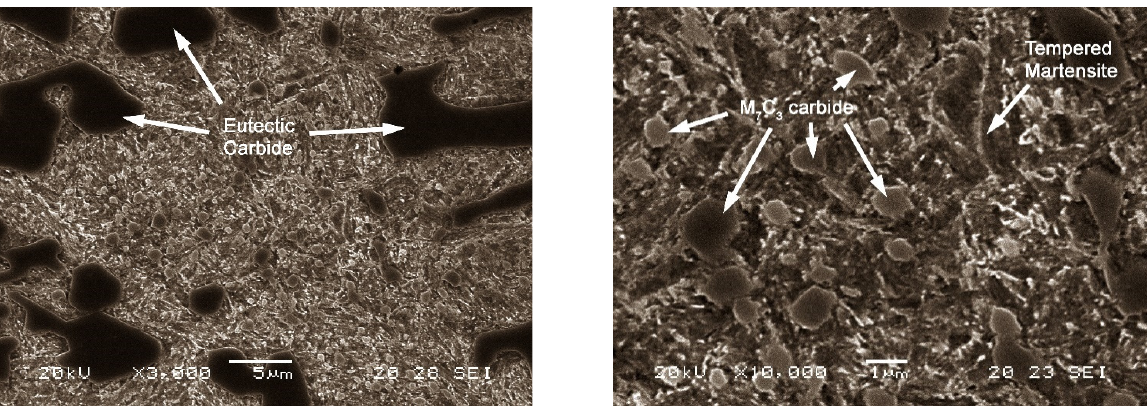
Figure 12. Microstructure corresponding to experiment 8. A high density of carbides in the matrix can be observed. With regard to the values in Table 4, the presence of carbides of the M 2 C type, asso ‐ ciated with Mo is confirmed for Table 8. Figure 13 shows a BEI image confirming the pres ‐ ence of this carbide with skeletal morphology which is nucleated from the eutectic M 7 C 3 [38]. Table 8. Semi-quantitative analysis of phases shown in Figure 13a,b. This analysis was carried